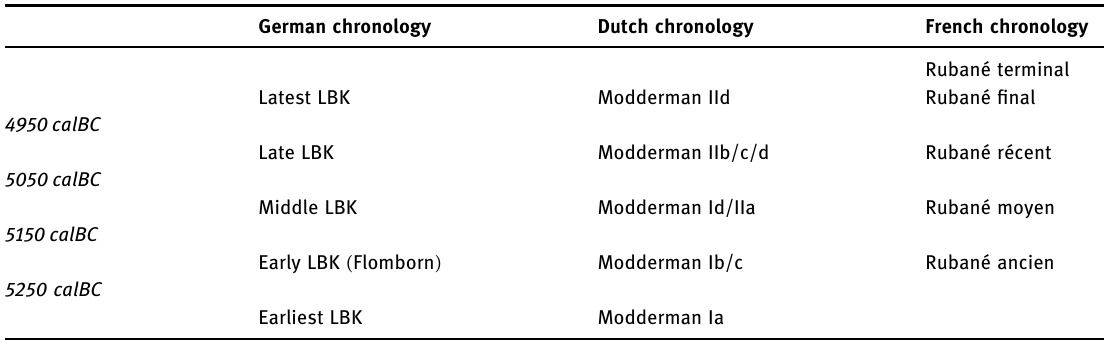
Table 1: Chronology of LBK and synchronization between German, Dutch, and French chronology ( simpli fi ed based on Gomart, 2014, p. 41